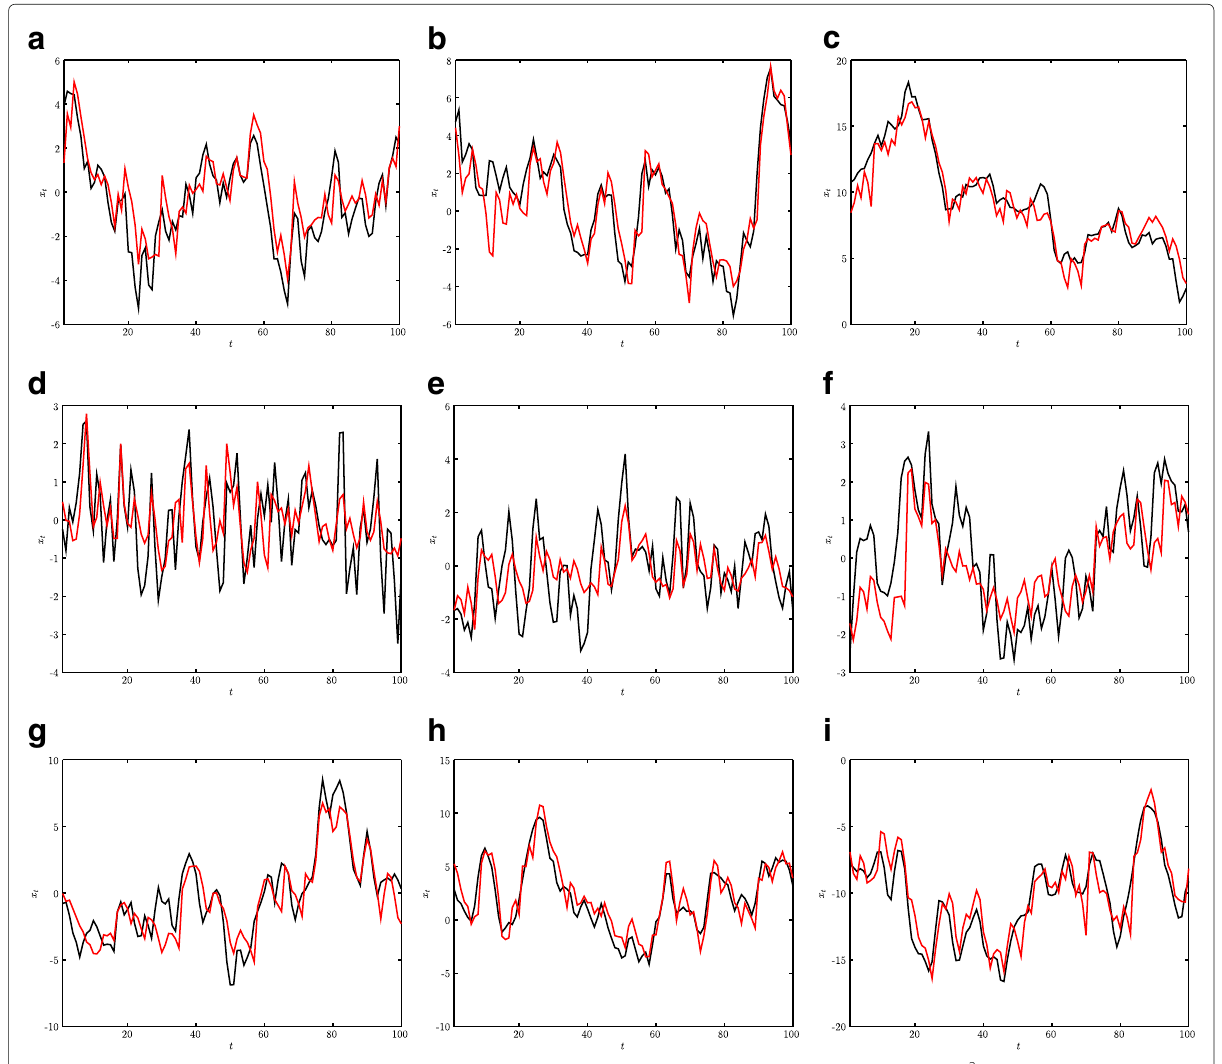
Fig.2 True(black)andestimatedstate(red)fortheproposedSMCmethodwithknownARMAparametersandunknown σ 2 u a AR ( 1 ) , a 1 = 0.85, H = 0.5. b AR ( 1 ) , a 1 = 0.85, H = 0.7. c AR ( 1 ) , a 1 = 0.85, H = 0.9. d MA ( 1 ) , b 1 = 0.8, H = 0.5. e MA ( 1 ) , b 1 = 0.8, H = 0.7. f MA ( 1 ) , b 1 = 0.8, H = 0.9. g ARMA ( 1,1 ) , a 1 = 0.85, b 1 = 0.8, H = 0.5. h ARMA ( 1,1 ) , a 1 = 0.85, b 1 = 0.8, H = 0.7. i ARMA ( 1,1 ) , a 1 = 0.85, b 1 = 0.8, H =